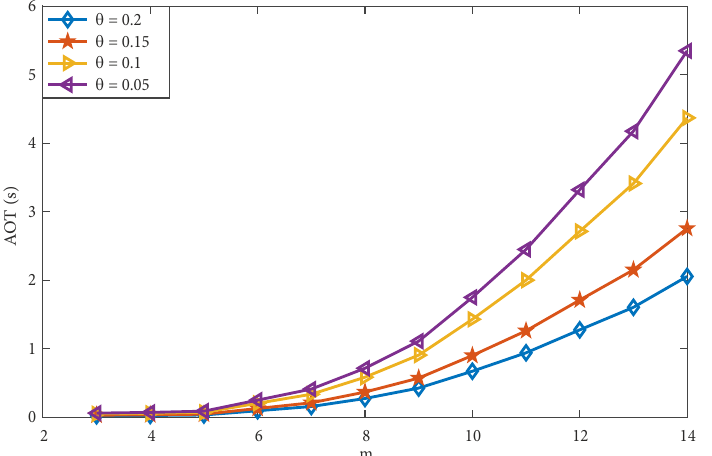
Figure 3. The AOT with various values of q when m is taken from 3 to 14 (sources: authors’ own research)